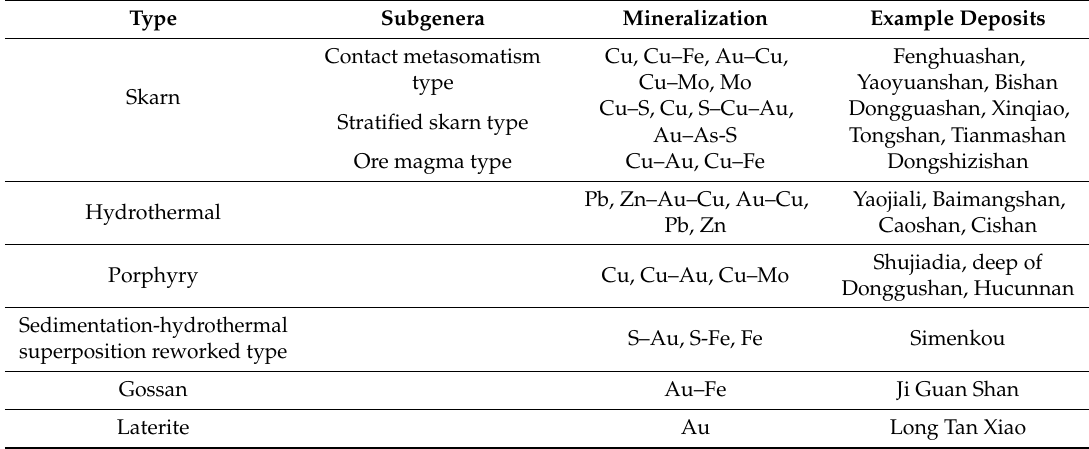
Table 1. Classification of metal ore deposits in the Tongling ore-cluster